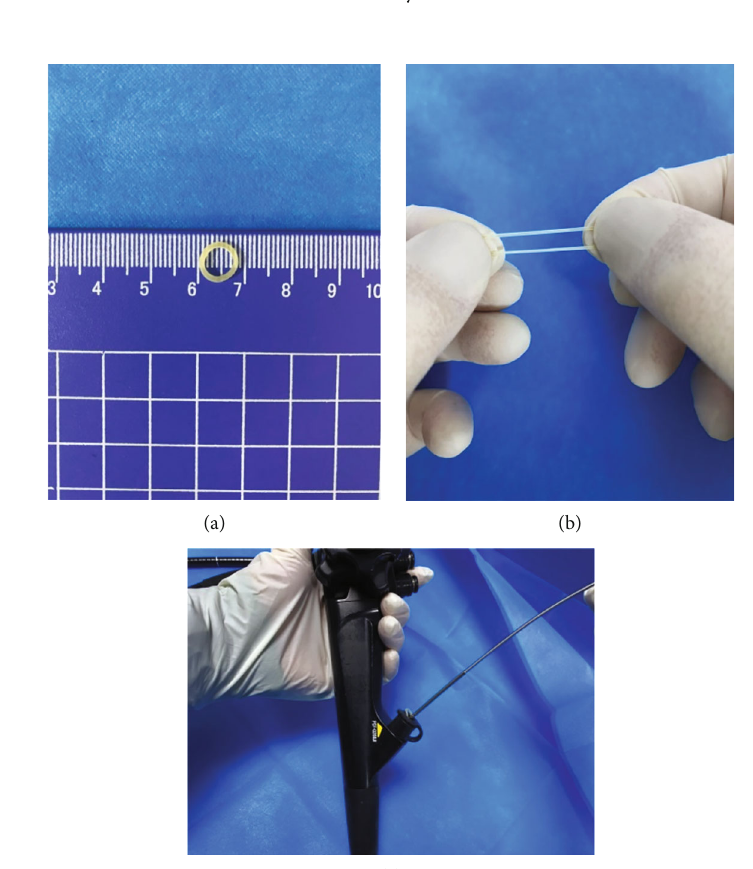
Figure 2: Diagram showing the application of an orthodontic rubber band (ORB): (a) the inner diameter of the ORB; (b) good elasticity of the ORB; (c) an ORB passed through the working channel of the